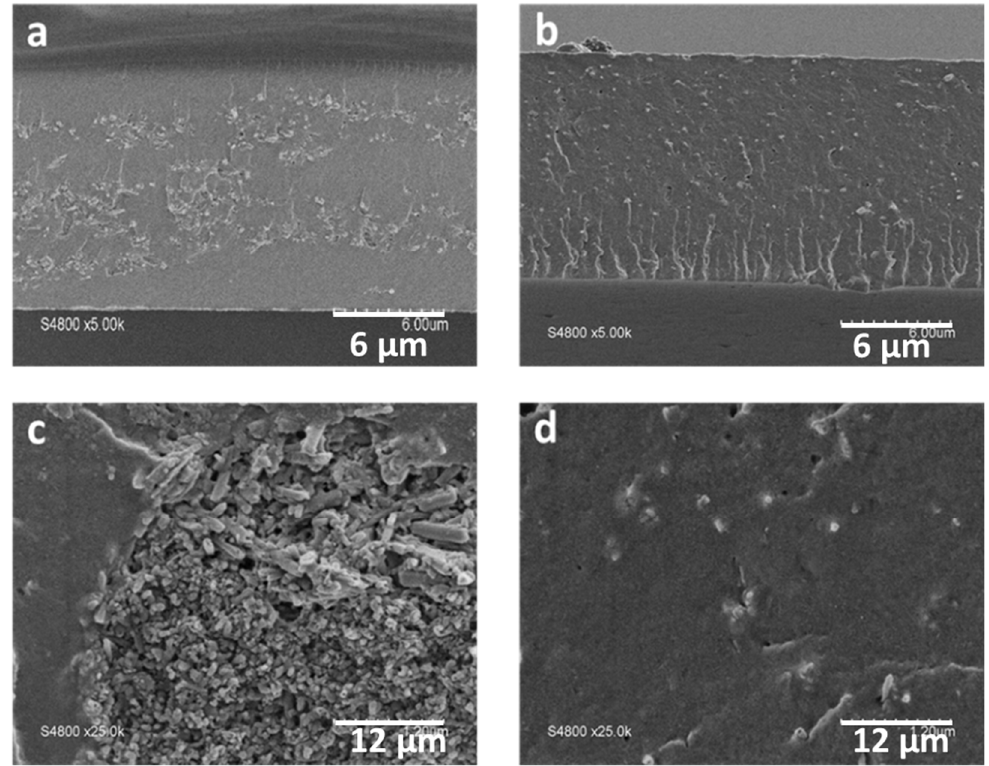
Figure 5. SEM images of the cross section of composite membrane with Aquivion ® loaded with 10 wt% HNT ( a , c ) and HNT-NH 2 ( b , d ).